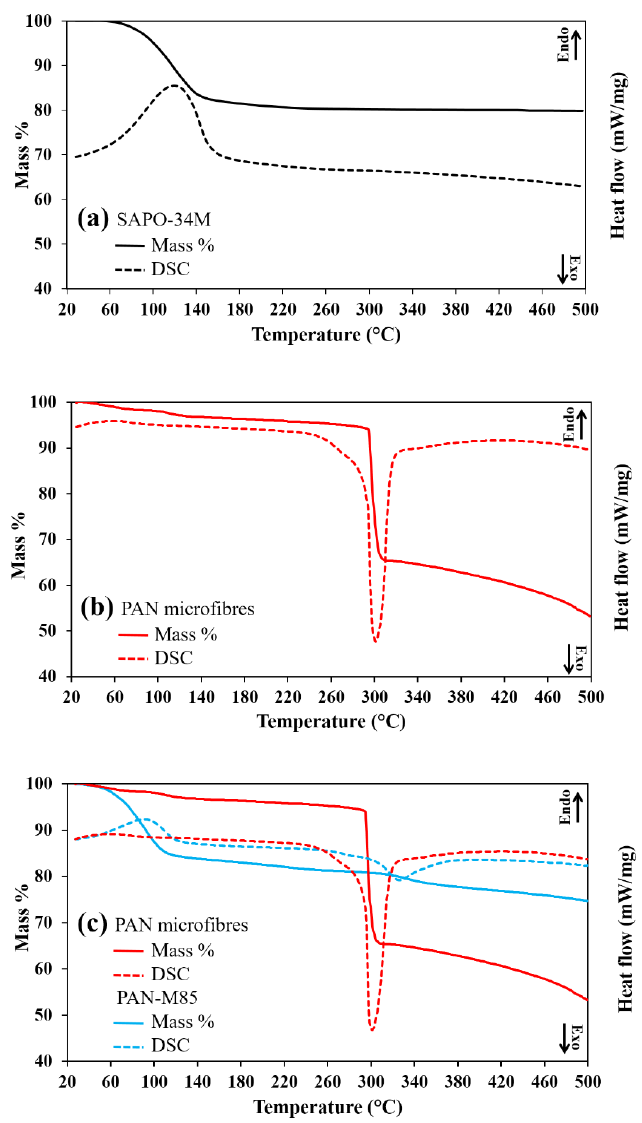
Figure 6. TGA-DSC curves of SAPO-34M ( a ), PAN microfibers ( b ) and sample PAN-M85 ( c ).